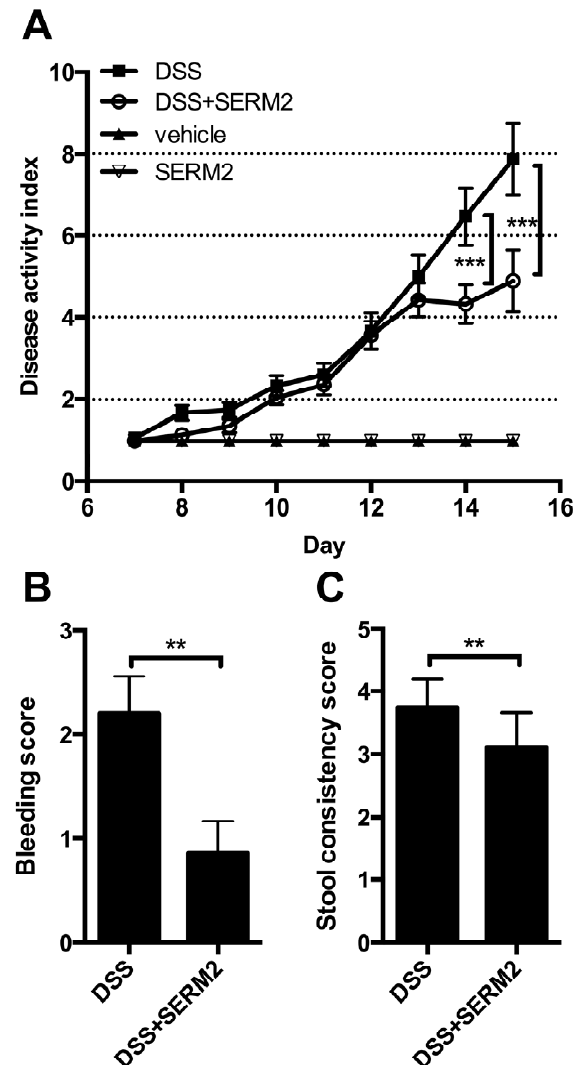
Figure 2. SERM2 alleviates severity of symptoms related to DSS-induced (days 7–14) colitis. ( A ) E ff ect of SERM2 feeding (10 mg / kg bw, every third day) on disease activity index, consisting of rectal bleeding, stool consistency, and weight loss. ( B ) Bleeding and ( C ) stool consistency of DSS mice at sacrifice, and ( D ) full colon lengths. The data are pooled from two independent experiments (except for D) and expressed as the mean ± SEM. Statistical significance calculated with two-way ANOVA (one-way for D) and Bonferroni post hoc test. * p < 0.05; ** p < 0.01; *** p <